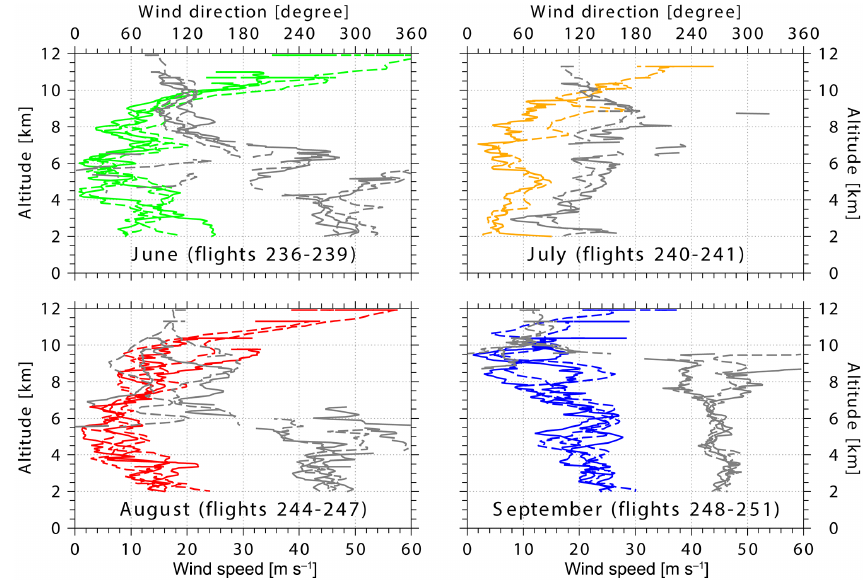
Figure 8. Wind speed (coloured lines, lower x axis) and wind direction (grey lines, upper x axis, 90 ◦ means wind from the east, 180 ◦ from the south, 270 ◦ from the west) as recorded by the CARIBIC aircraft for the descent into (solid lines) and ascent from (dashed lines) Chennai. Only data south of 16 ◦ N and above 2km altitude are plotted. Chennai is at 12.99 ◦ N, 80.18 ◦ E.